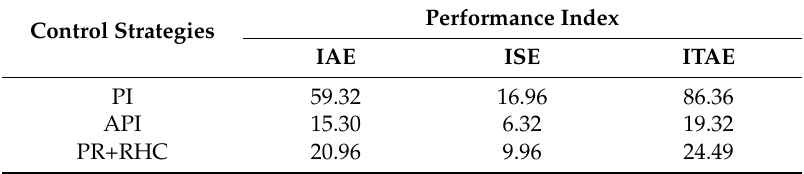
Table 16. Performance evaluation of the designed control strategies for I q